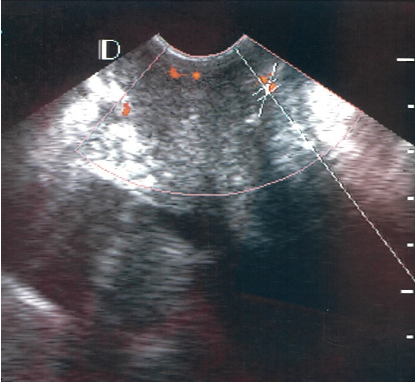
Figure 2. Example of Class II vascularity. There are 4–5 vascular hotspots (orange color) and each size was measured as about 1–2 mm.